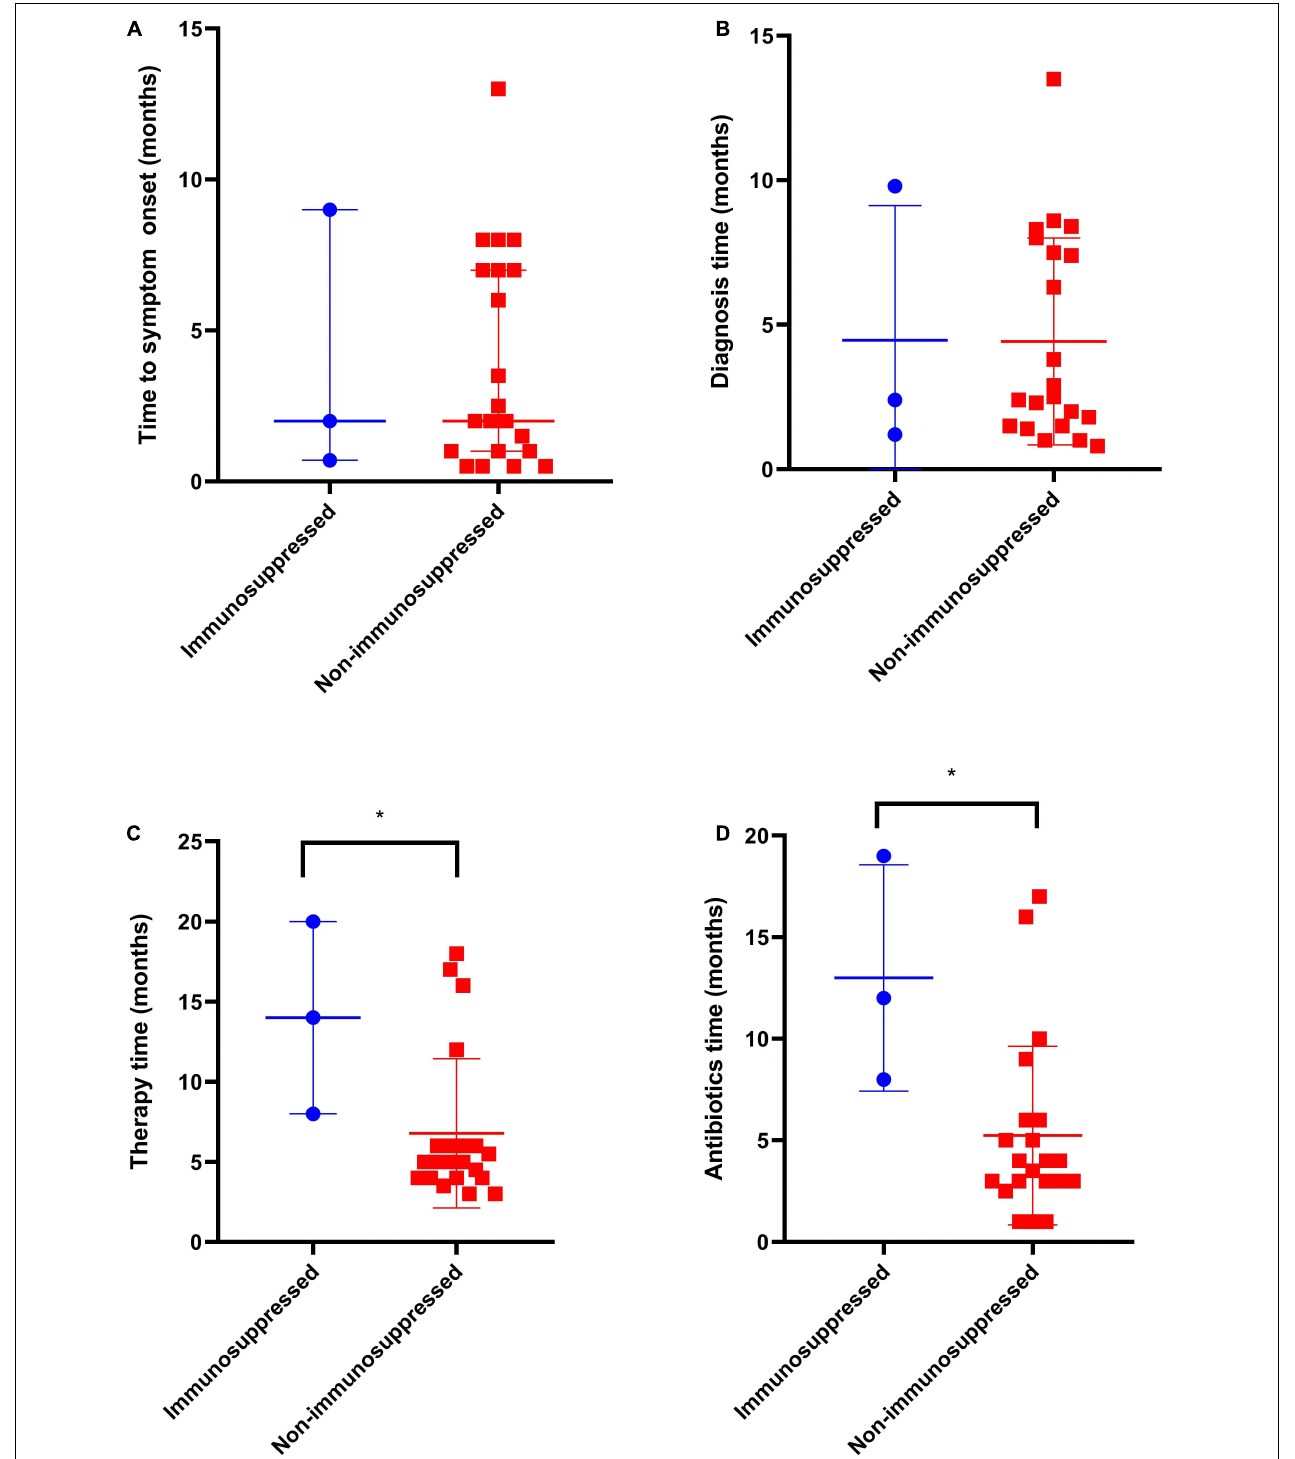
FIGURE 2 | Comparison of clinical manifestations and duration of therapy of immunosuppressed ( n = 3) and non-immunosuppressed patients ( n = 21). (A) Time to symptom onset, (B) Time from symptom onset to diagnosis, (C) Total duration of therapy, months, and (D) Time from last infection control surgery to cessation of antimicrobial therapy, months. * p <